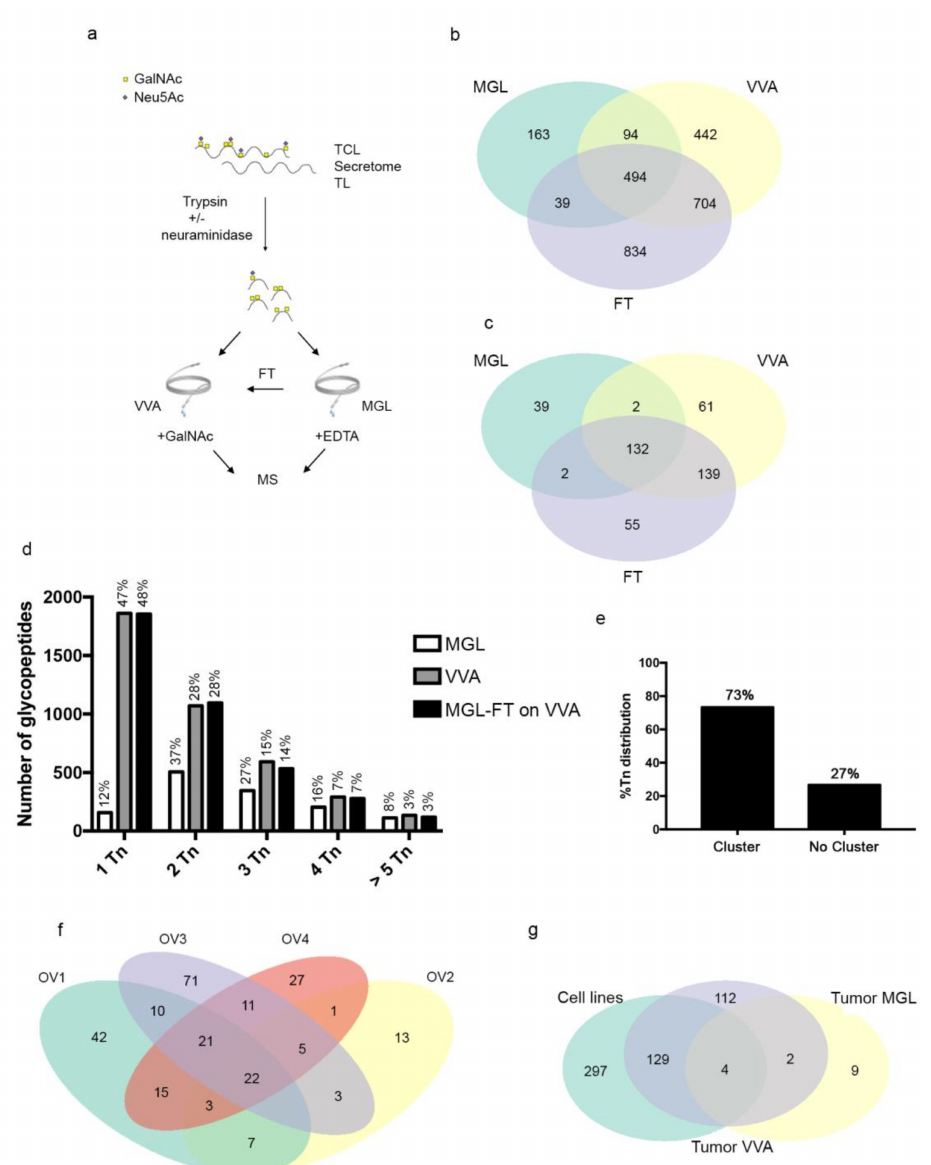
Figure 3. O -glycoproteome analysis of ovarian cancer cells and tissues by LWAC. ( a ) Schematic depiction of LWAC strategy to identify the O -glycoproteome of SKOV-3 Simple Cells (SC) and OVCAR-3 SC ovarian cancer cell lines (total cell lysates (TCL) and secretome and tumor cell lysates (TL)). ( b , c ) Venn diagrams showing distribution of Tn-glycopeptides ( b ) and Tn-glycoproteins ( c ) identified by rhMGL- or VVA–LWAC. FT refers to samples first enriched by MGL–LWAC followed by VVA–LWAC enrichment on the flow-through. ( d ) Histograms representing the accumulated total number of glycopeptides carrying di ff erent moles of Tn-glycans isolated from TCL and secretome of ovarian cancer cell lines by rhMGL (white bars), VVA (gray bars), and the flow-through of MGL–LWAC analyzed by VVA–LWAC (black bars). Values on top of histograms represent the percentage of the total Tn-carrying glycopeptides identified in the three experimental settings. ( e ) Histograms reporting the percentage of MGL peptide binders carrying Tn-residues clustered on adjacent amino acids (cluster) or present in isolated sites (no cluster). ( f ) Venn diagrams showing distribution of Tn-glycoproteins isolated from four ovarian cancer tumor samples by rhMGL- or VVA–LWAC. ( g ) Venn diagrams showing distribution of Tn-glycoproteins from tumor cells and ovarian cancer cell lines identified by rhMGL- or